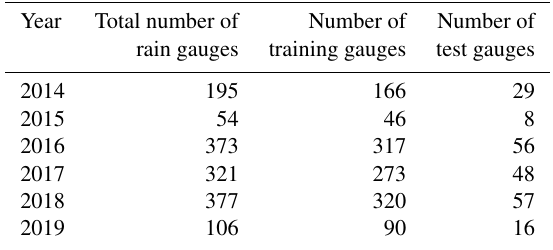
Table 2. Number of rain gauges for training and testing in 2014–